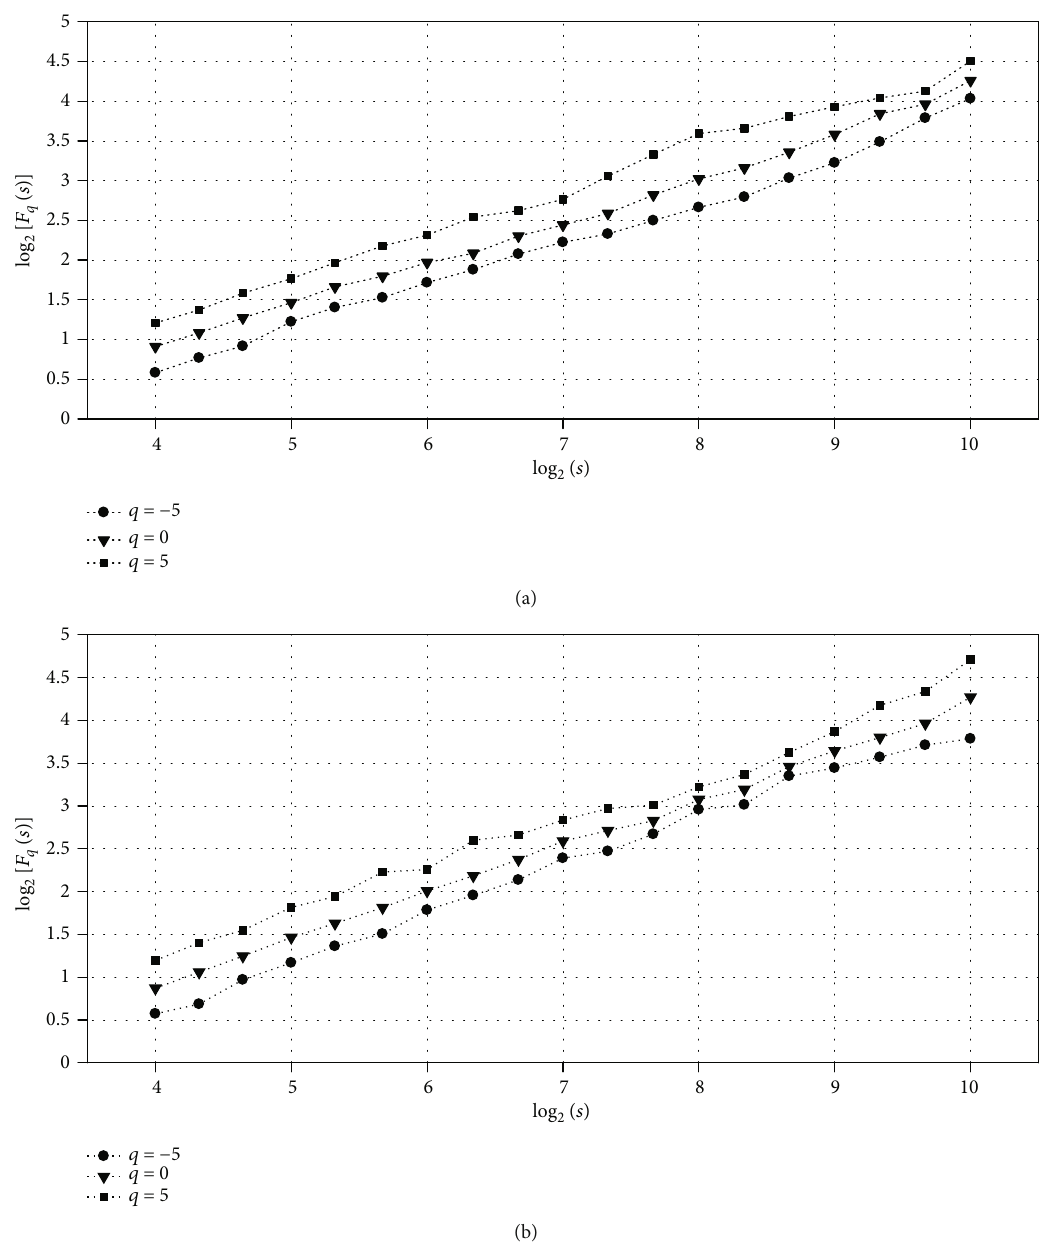
Figure 4: Trend of log ½ F q ð s Þ(cid:2) vs log ½ s (cid:2) s for q = − 5, 0, 5 , analyzed for the ϕ space corresponding to the η space for (a) 8 TeV dataset, as 2 2